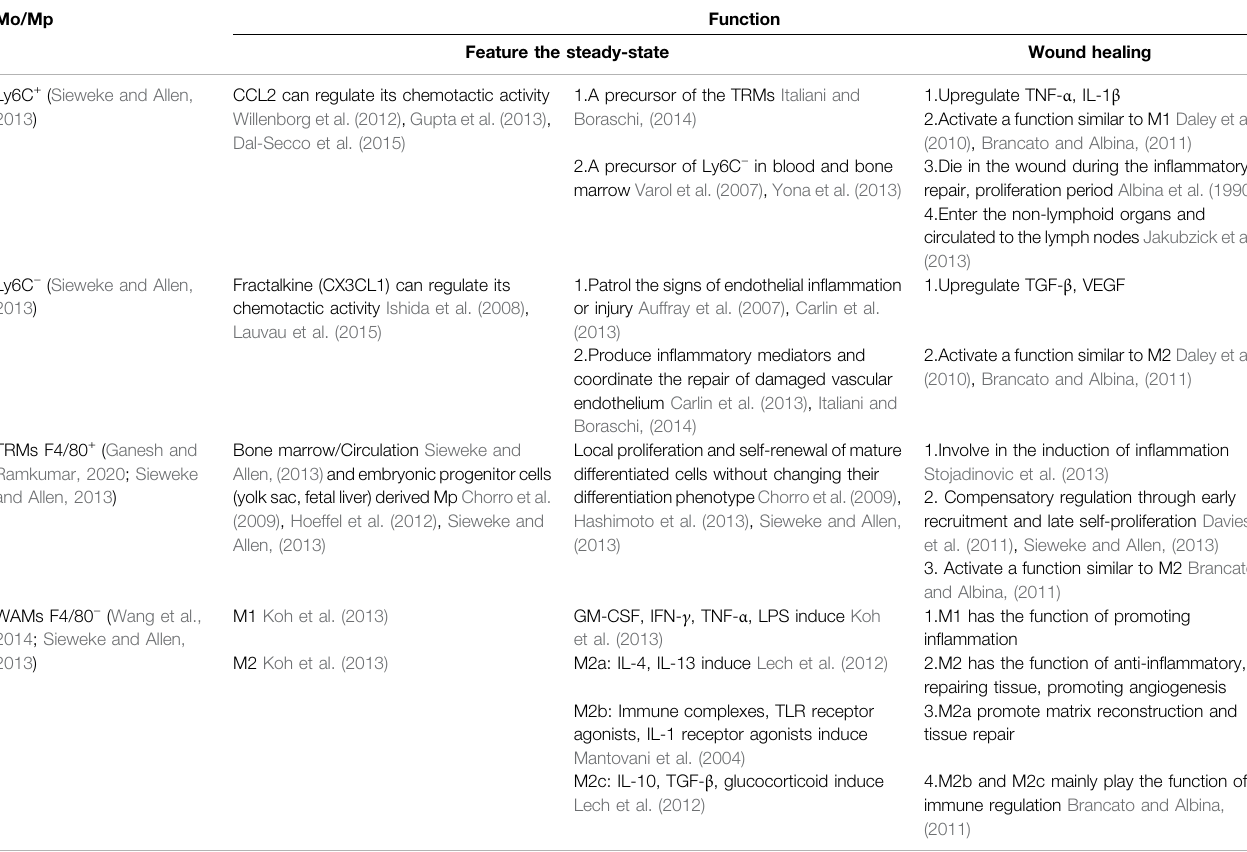
TABLE 2 | Function and relationship of Mo/Mp subpopulations in wound homeostasis and repair. Mo/Mp Function Feature the steady-state Wound